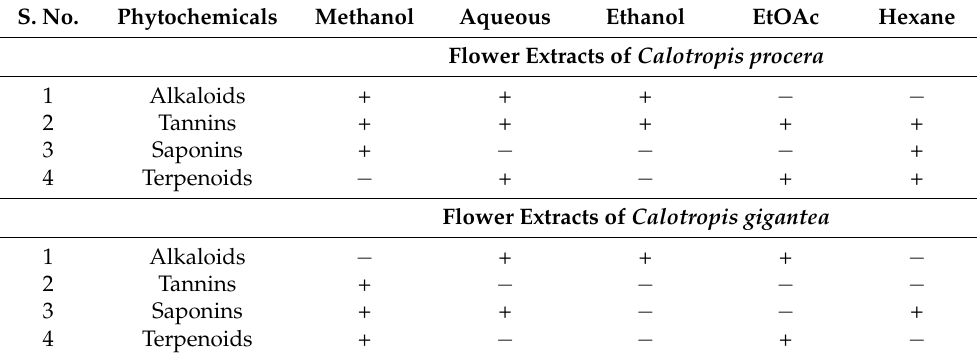
Table 2. Cont. S. No.